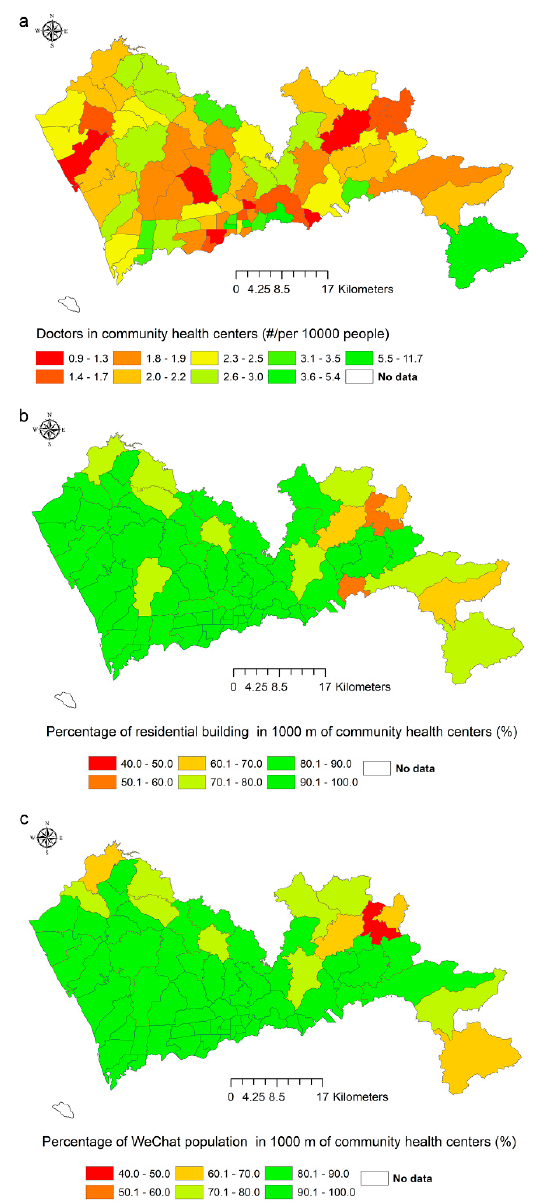
Figure 3. Values of the indicator of health services in 74 sub-districts. ( a ) The number of doctors in community health centers per 10,000 people; ( b ) the percentage of residential buildings ≤ 1000 m to community health centers; ( c ) the percentage of WeChat population ≤ 1000 m to community health centers.